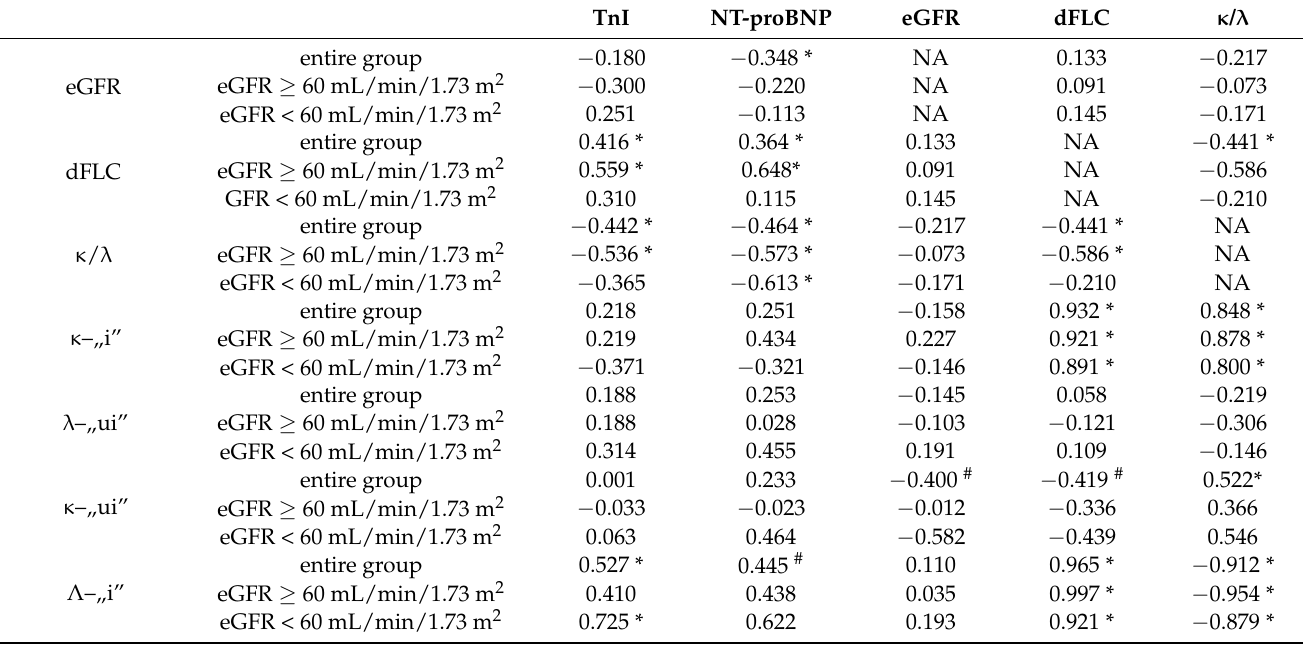
Table 3. Correlations of the concentrations of κ and λ free light chains (involved and uninvolved), dFLC values, and the κ / λ ratio with biochemical parameters of cardiac involvement and the eGFR values in the group with myocardial amyloid involvement, depending on the value of